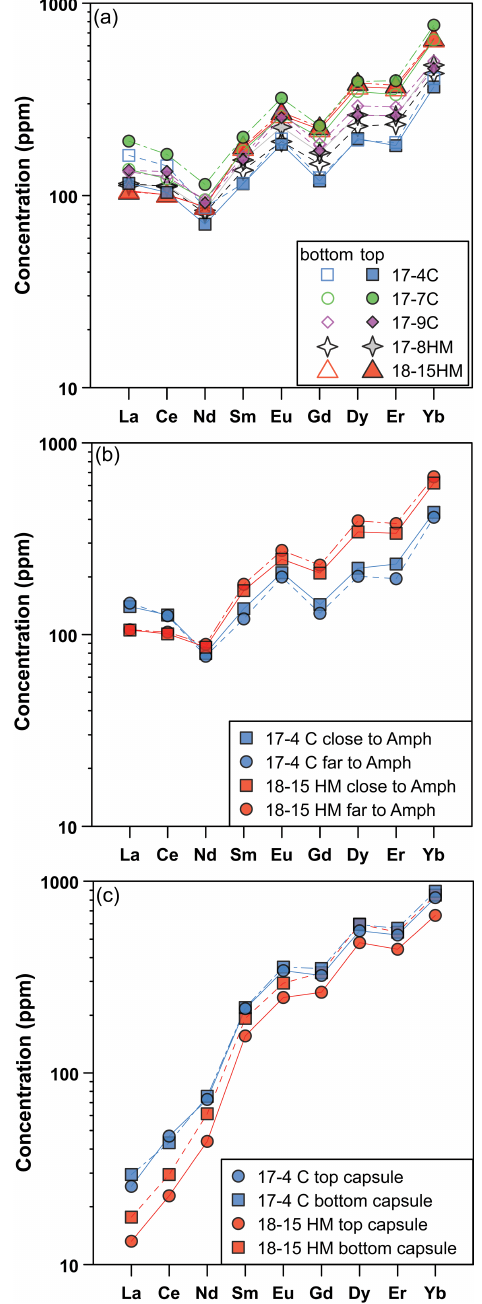
Figure 5. Rare Earth element (REE) concentrations (in ppm) of glass (a, b) and amphibole (c) in experiments as a function of their location in the experimental charges (at top and bottom, a and c ) and the REE composition of the glass close and far with respect to the amphibole grains (b) . These patterns reveal rather homogeneous REE concentrations in glass and amphibole from the experimental charges. In (b) and (c) are shown experiments 17-4C and 18-15HM as representative of low and high f O 2 conditions,